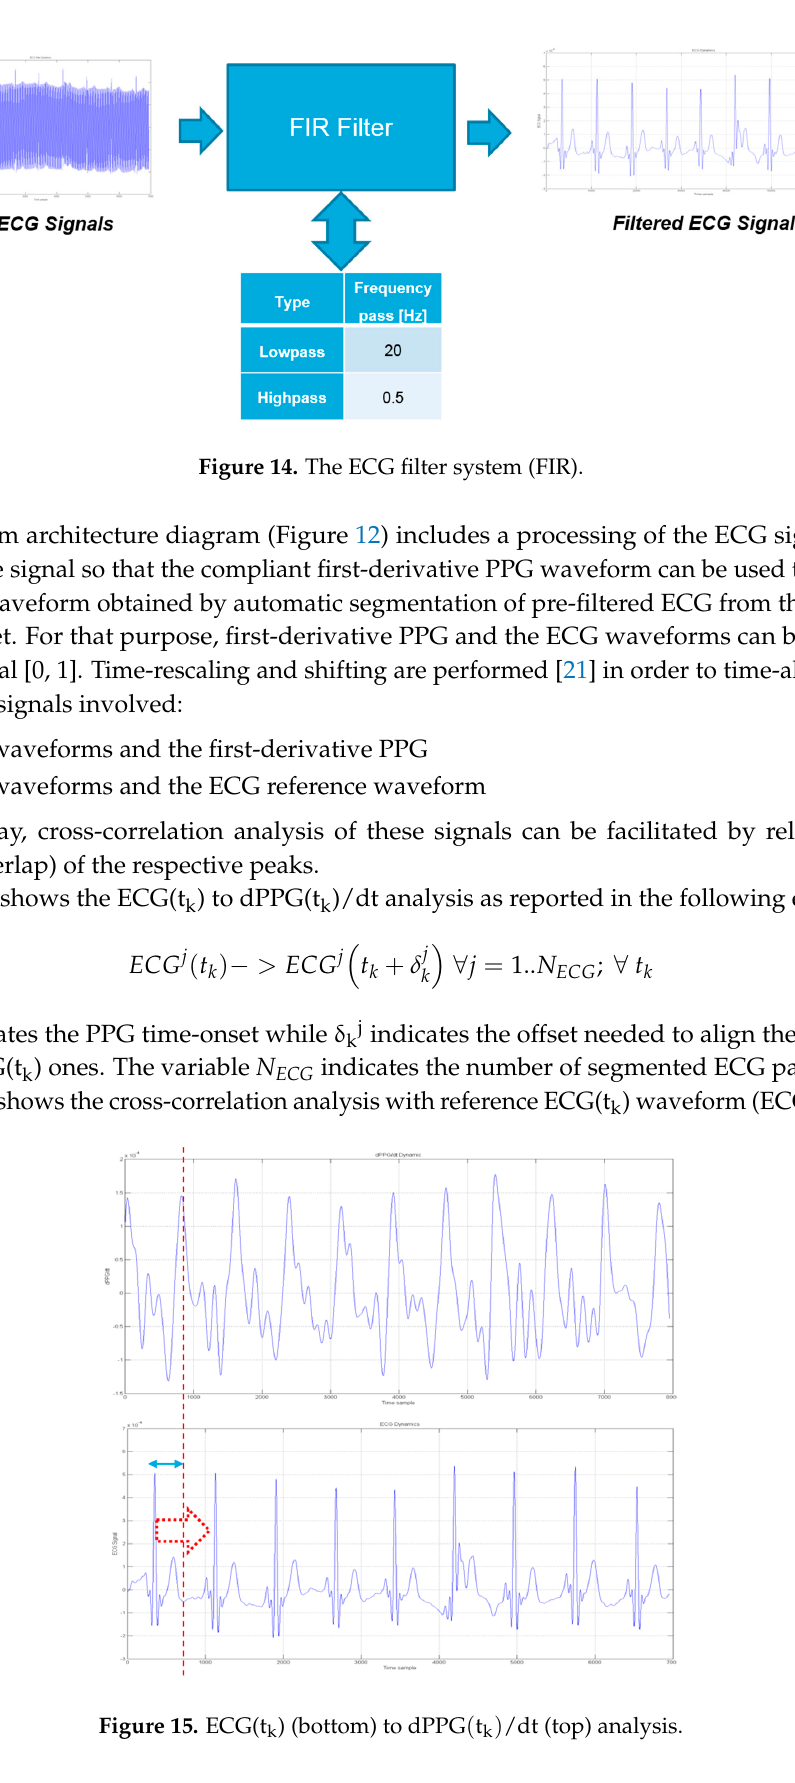
Figure 16. The ECG(t k ) to ECG ref (t k ) analysis: t k indicate the PPG/ECG time-onset. For all ECG(t k ) segmented waveforms (N ECG ), the alignment between ECG ref (t k ) peak with ECG(t k ) ones is obtained with same signal re-mapping as per Equation (4). Finally, a standard sample cross-correlation analysis is performed to generate respective cross-correlation scores (indexes) e.g., between rescaled-normalized ECG waveforms and first-derivative PPG waveforms and a standard ECG reference pattern. The obtained scores are compared with reference cross-correlation thresholds [29]. The whole proposed pipeline can be summarized as follows: